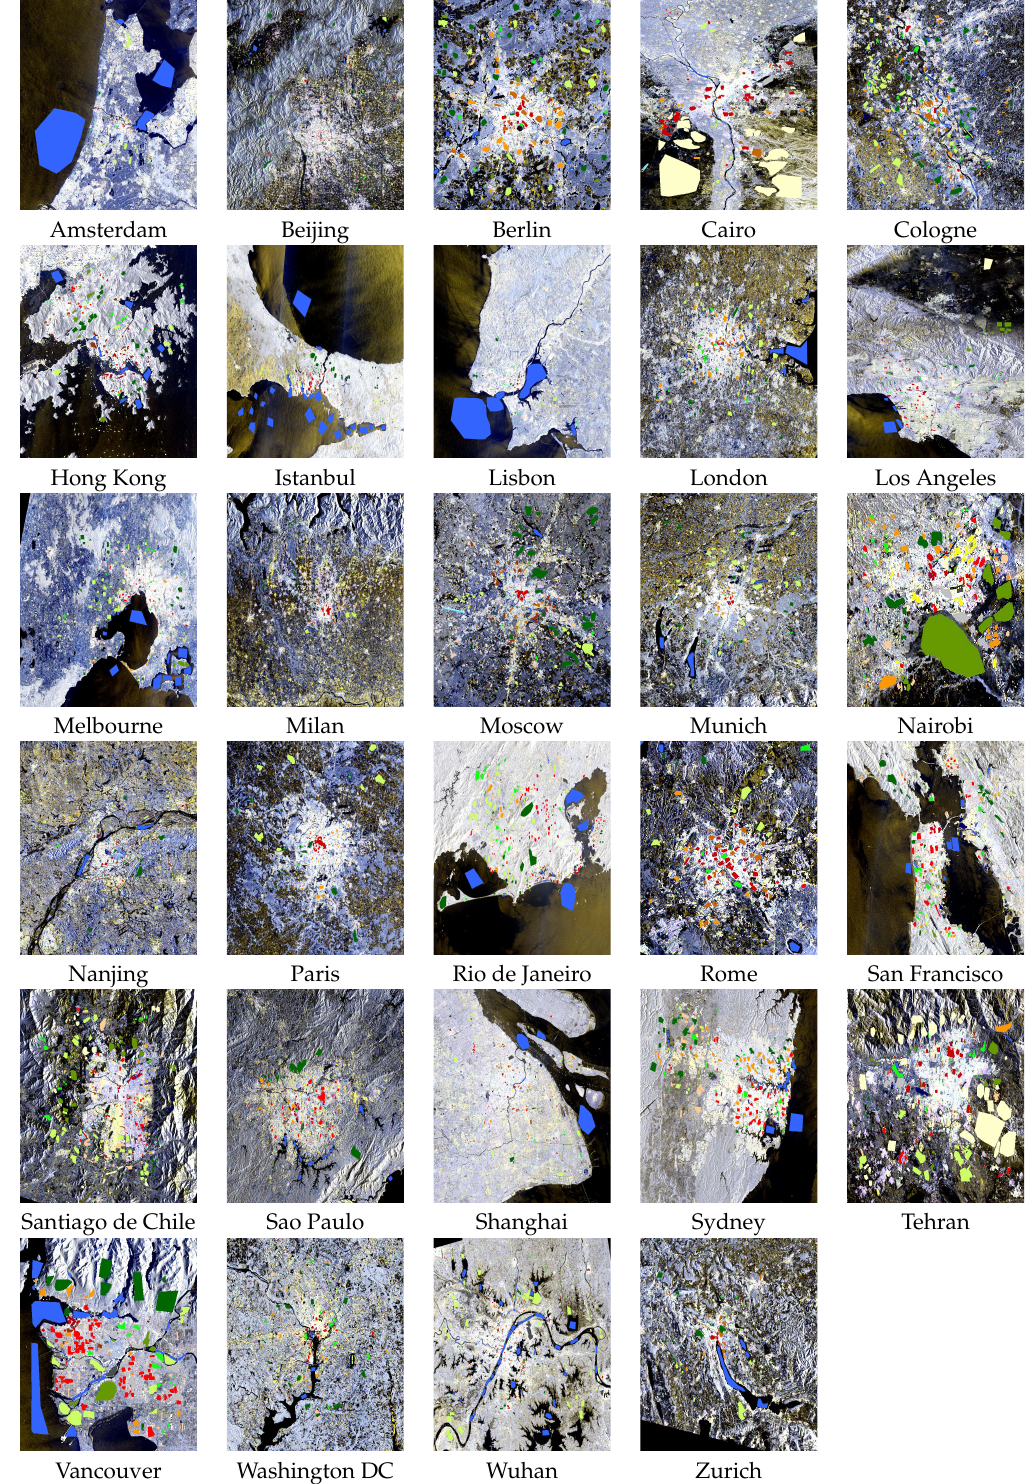
Figure 3. Processed Sentinel-1 Dual-Pol (VV and VH) data of 29 cities are shown in Pauli basis, overlapped with the labeled ground